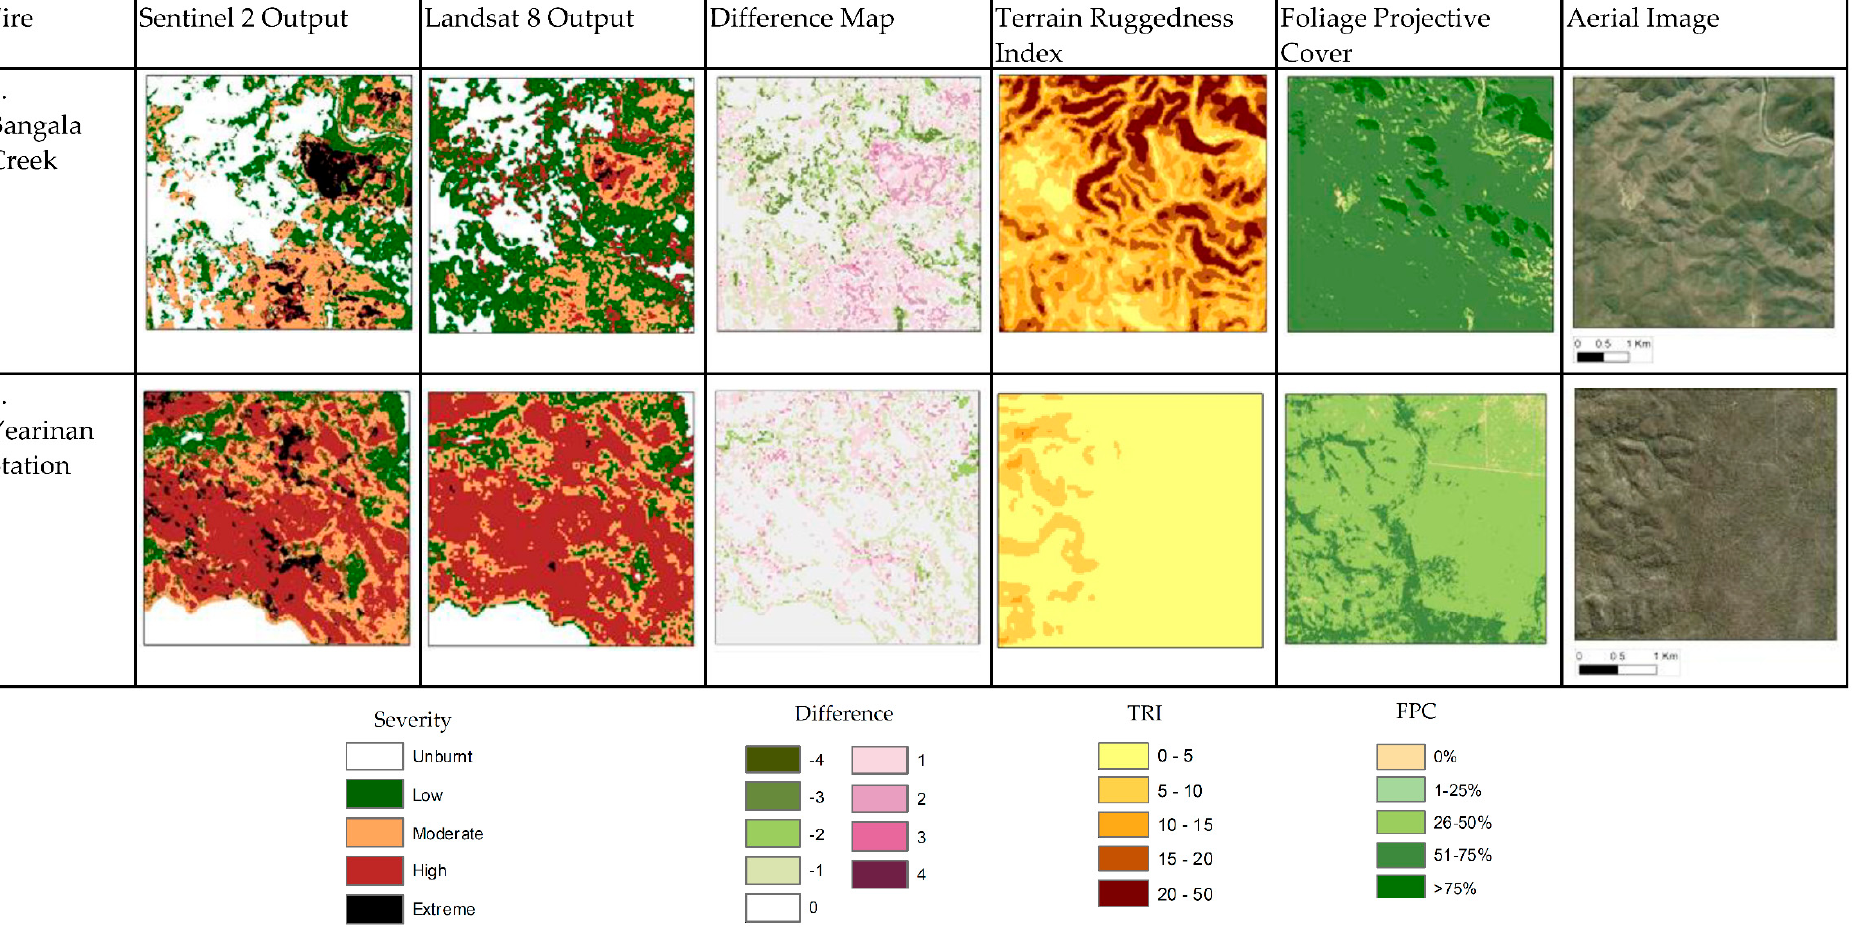
Figure 8. Excerpts from Bangala Creek and Yearinan Station study fires, showing the difference between severity outputs and the terrain ruggedness and foliage projective cover of the mapped area. Aerial imagery captured in 2012 showing the typical unburnt condition is also shown.